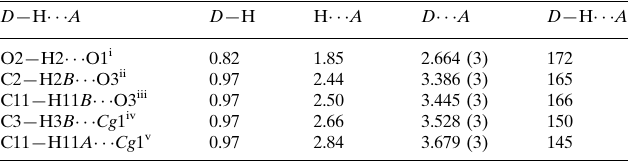
Hydrogen-bond geometry (A˚ , (cid:2)